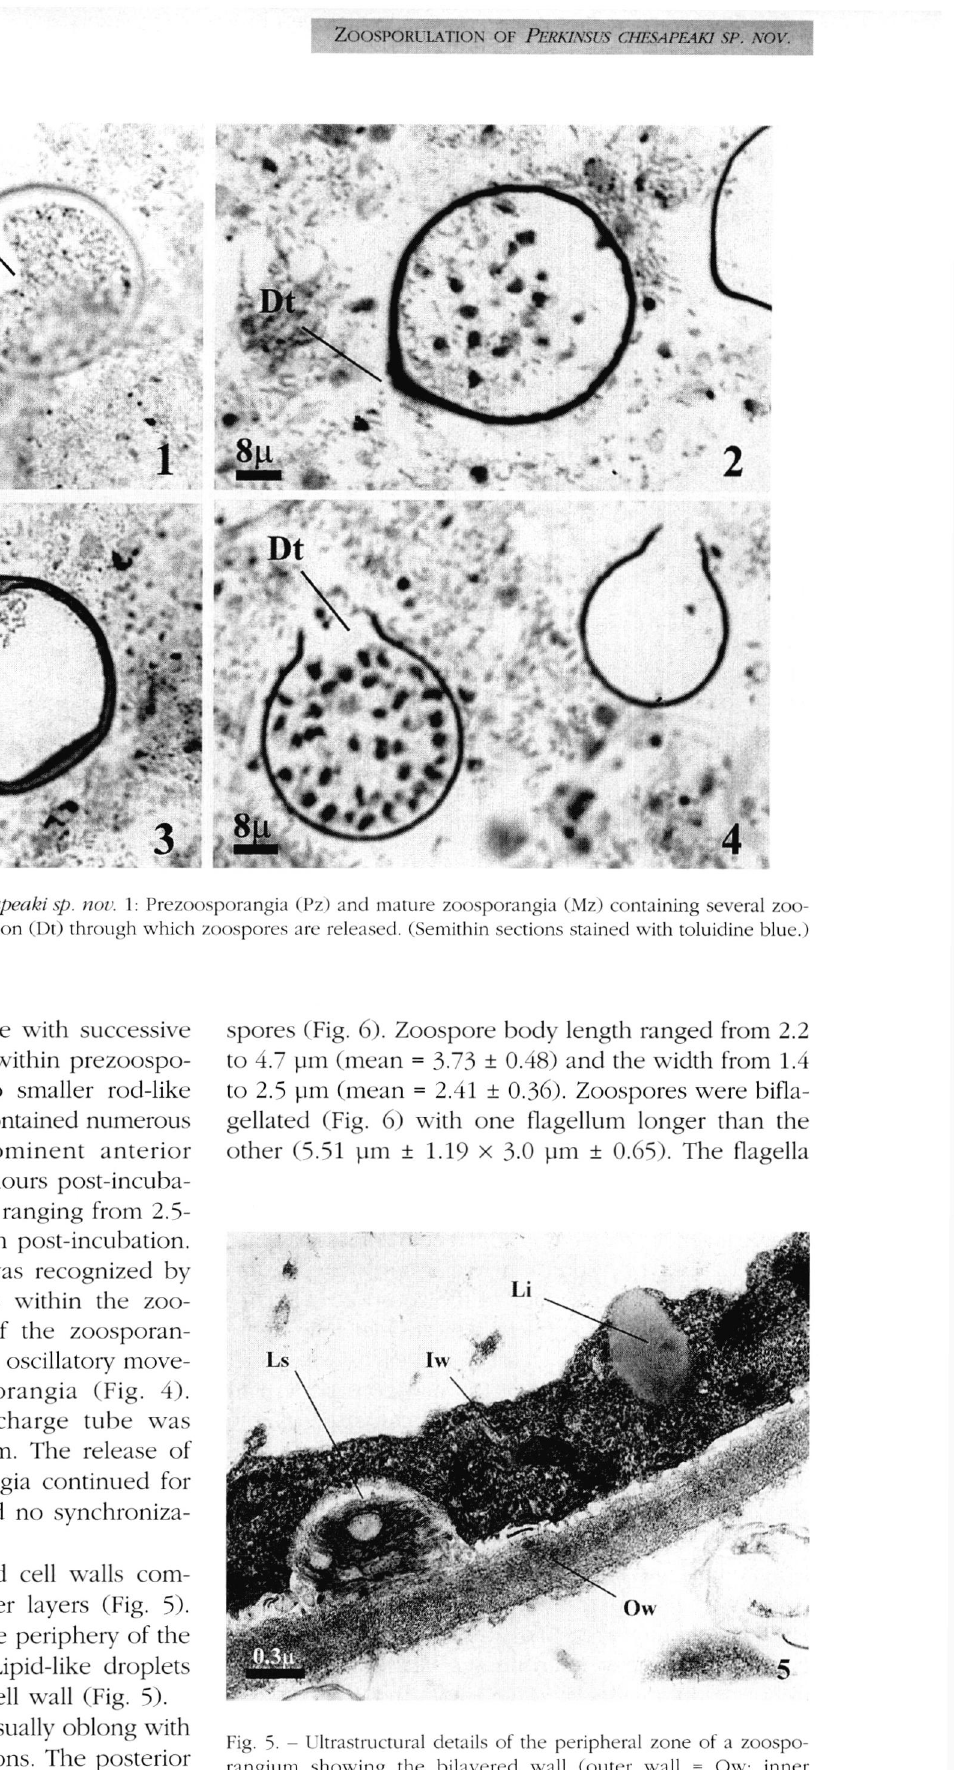
Fig. 5. - Ultrastructural details of the peripheral zone of a zoospo­ rangium showing the bilayered wall (outer wall = Ow; inner wall = Iw), a lamosome (Ls); and lipid-like bodies (Li).